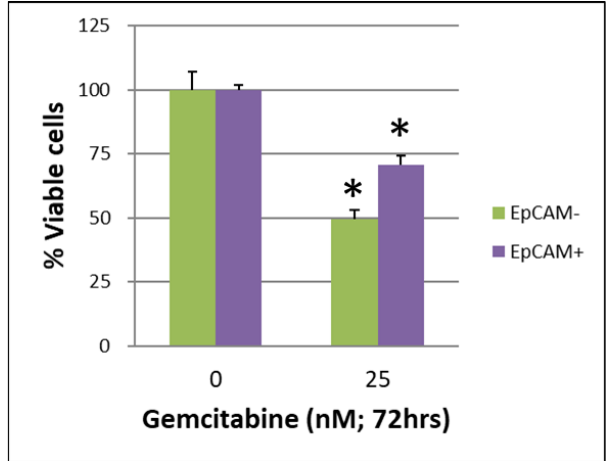
Figure 2. The survival of cancer stem cells EpCAM+/EpCAM− of BxPC-3 PDAC cells treated with or without gemcitabine (25 nM, 72 h) is shown. The EpCAM+ had better survival than EpCAM−, * < 0.05. (Mean ± SD).